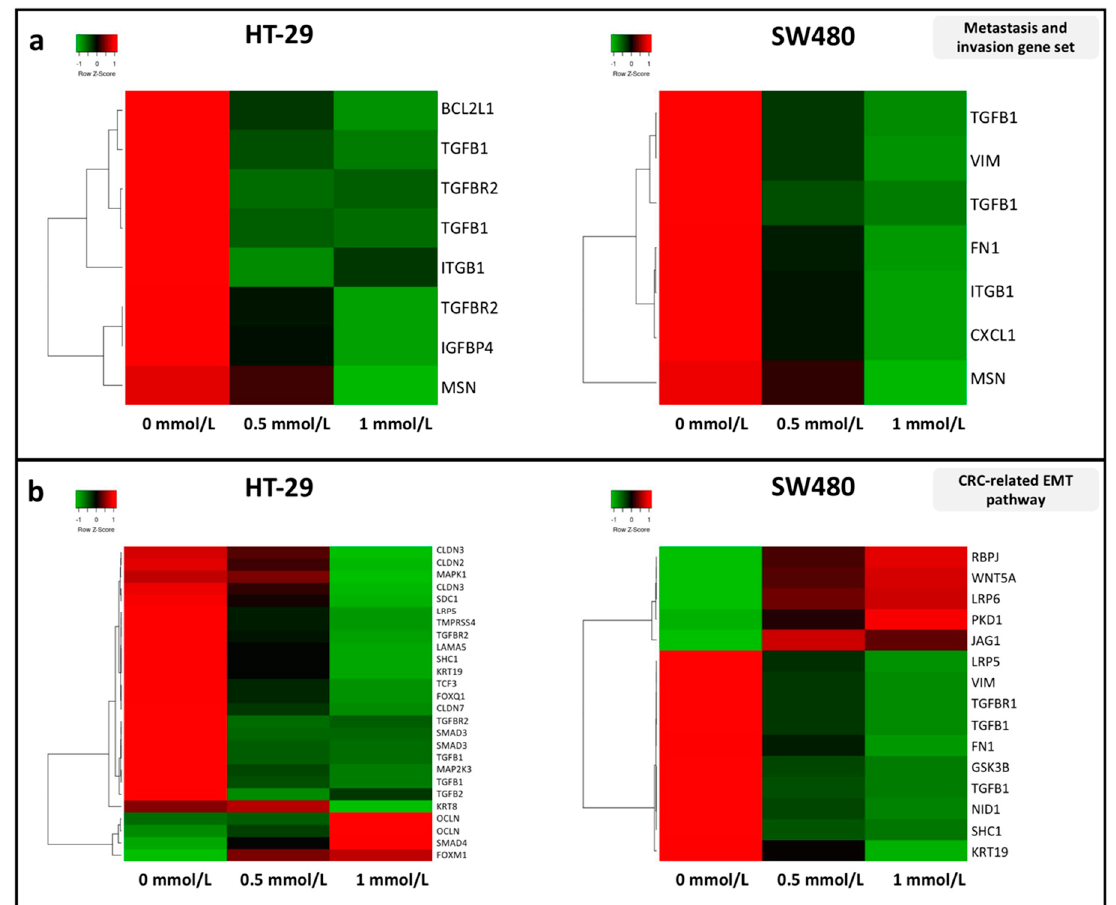
Figure 2. Expression analysis of genes included ( a ) in the gene set compiled by Bakhoum et al. [30] and ( b ) in the epithelial–mesenchymal transition (EMT) pathway comparing control (0 mmol/L) and SAM-treated (0.5 mmol/L; 1 mmol/L) HT-29 (left) and SW480 (right) cells. Transcripts that show significant ( p ≤ 0.05) alterations with a fold change (FC) ≥ |1.4| in the comparison of 0 and 1 mmol/L SAM treatment were illustrated on heatmaps. Columns are referred to the applied SAM concentration and each row represents a gene transcript probe set on the HTA 2.0 microarray platform (Affymetrix). Green color symbolizes downregulation, while red means increased expression.